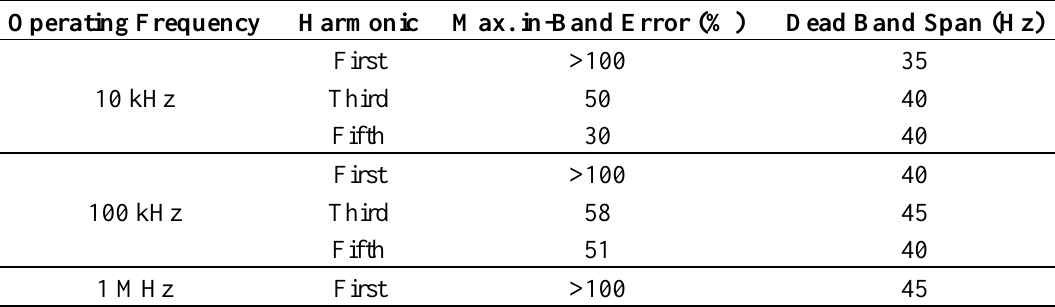
Table 3. Interference test results.